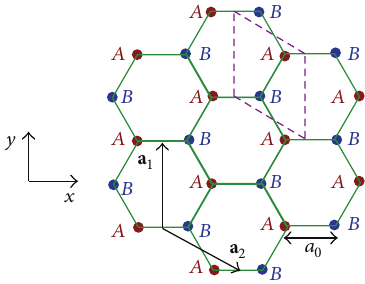
Figure 2: Schematic presentation of intra- ( 𝑡 ‖ ) and interplane ( 𝑡 ⊥ ) hopping to the NN sites in trilayer graphene for simple case (left) and Bernal one